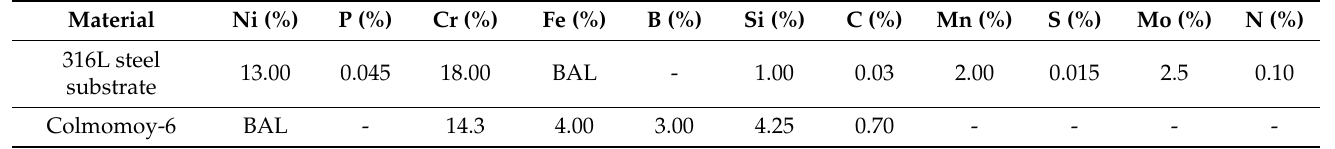
Table 1. Chemical composition of 316L steel and Colmonoy-6